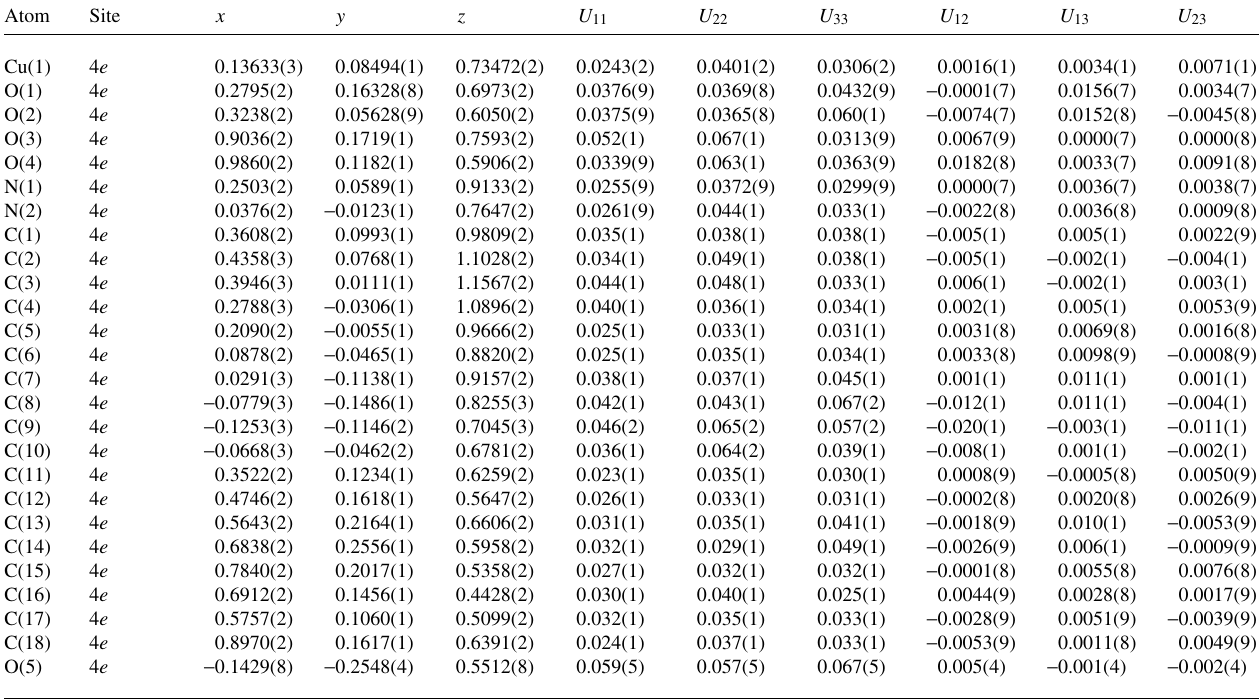
Table 3. Atomic coordinates and displacement parameters (in Å 2 ) .